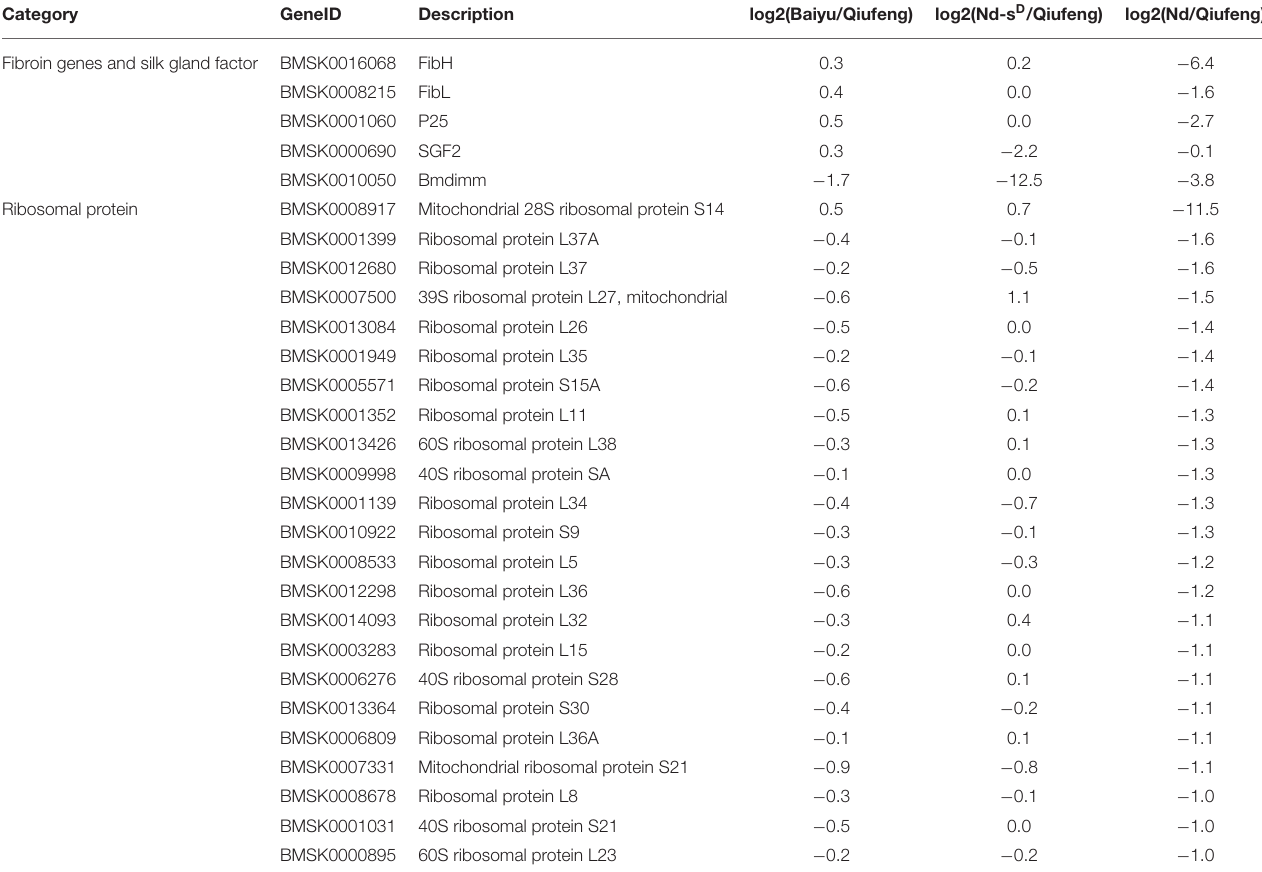
TABLE 1 | Differential expression genes associated with the biosynthesis of silk protein.